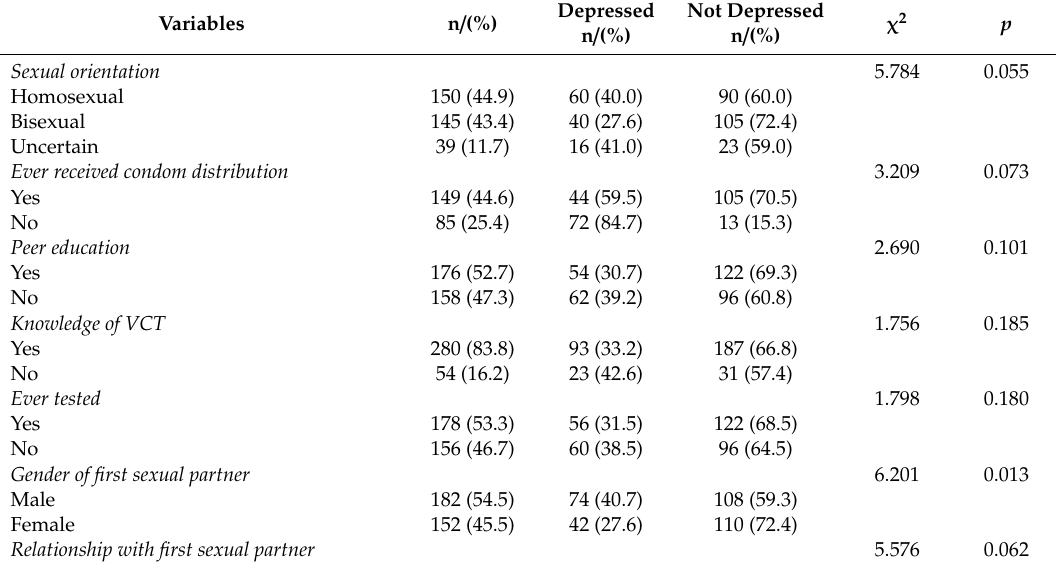
Table 3. Descriptions of sexual behaviors and services